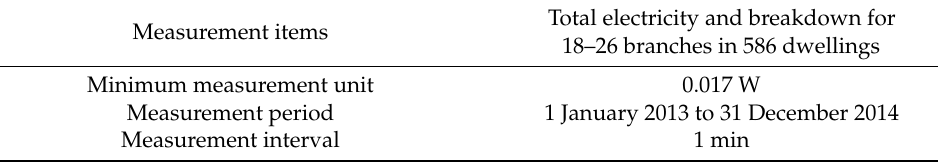
Table 2. Outline of energy demand